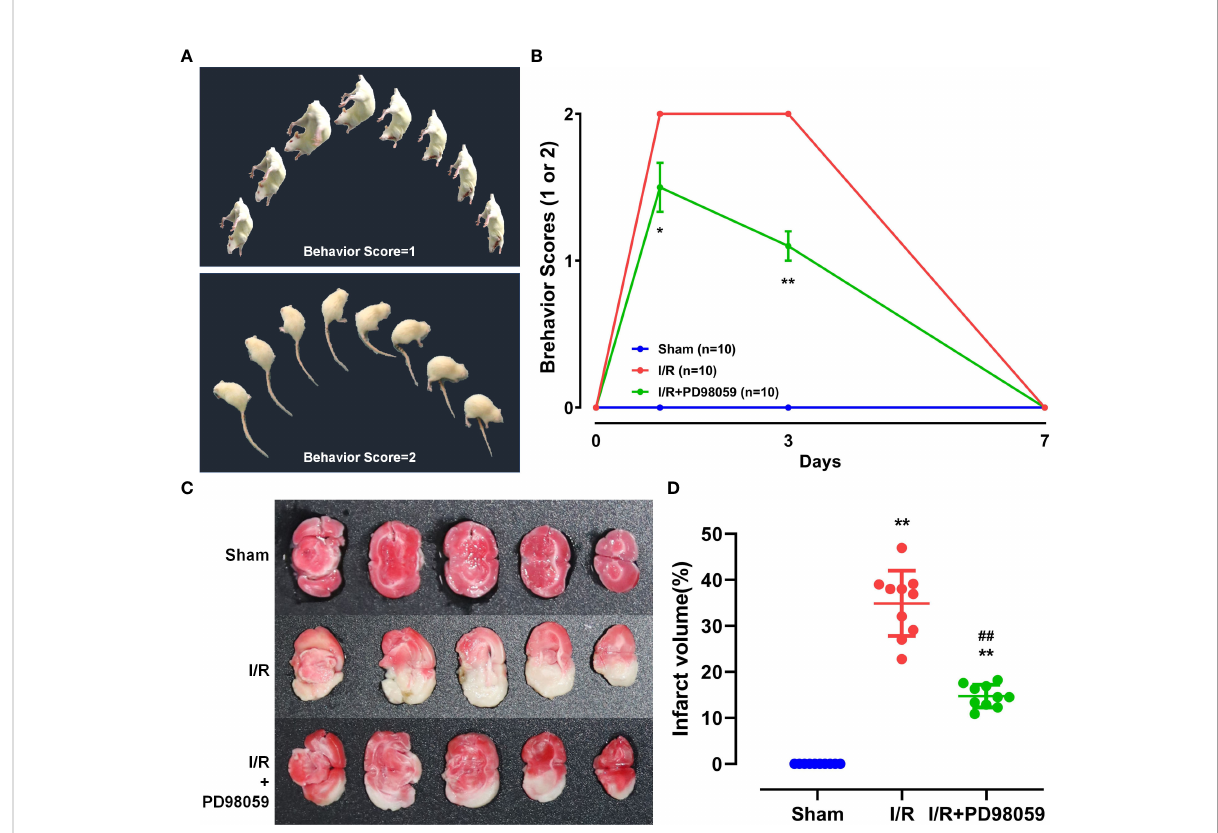
FIGURE 1 Neuroprotective function of ERK1/2 inhibitor on diabetic Rats. After cerebral I/R, rats ’ behavioral ability was evaluated by behavioral score and the infarct volume by TTC staining. (A) The behavioral score includes the schematic diagram of score 1 and 2. (B) Behavioral ability on the 0 th , 1 st , 3 rd , and 7 th day was compared between group I/R and I/R + PD98059 (Mean ± SD, n = 5). *p < 0.05; **p < 0.01. The celebral I/R induced infarct volume in different groups was determined by TTC staining (C) and the difference was calculated (Mean ± SD, n = 5) (D) . **p < 0.01, I/R + PD98059 or I/R vs Sham; ## p < 0.01, I/R + PD98059 vs